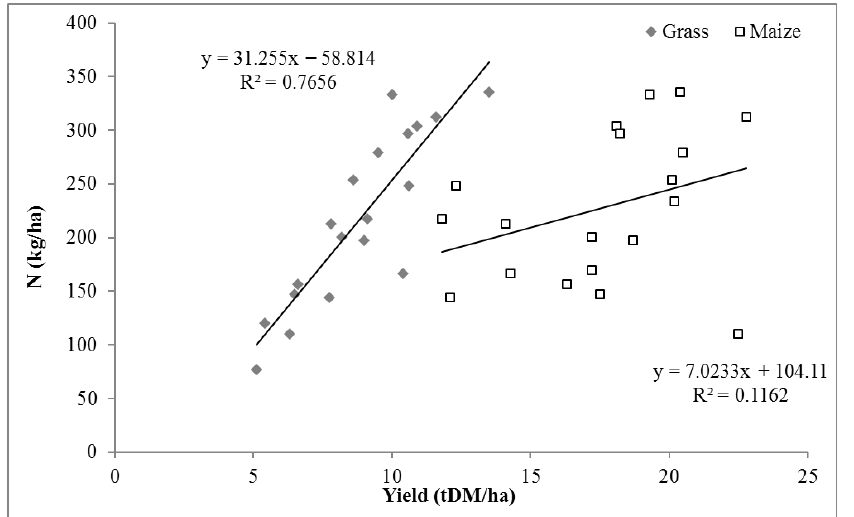
Figure 4. Linear regression between grass or maize yield and total amount of nitrogen distributed per hectare (mean values for all crops) on the farms.